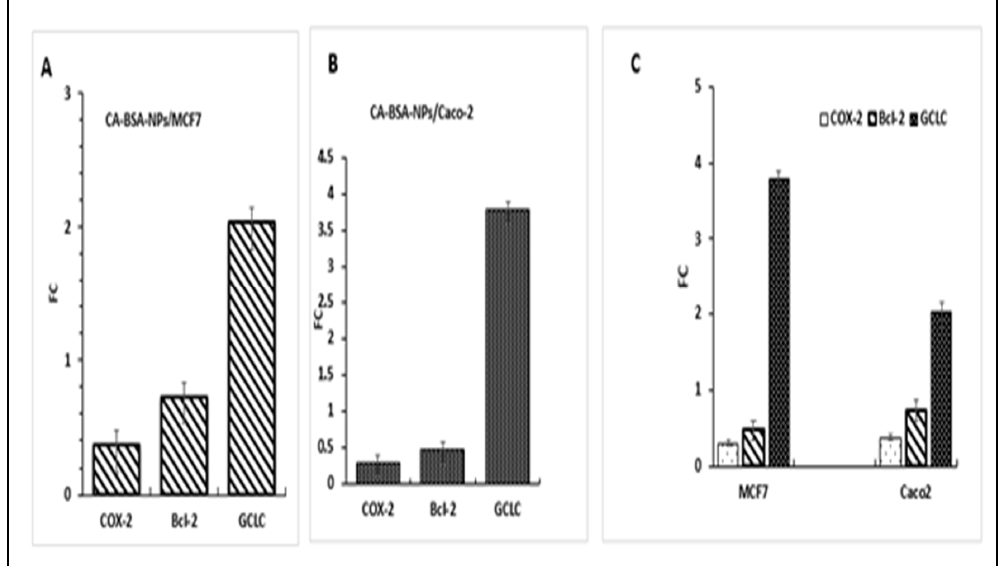
Figure 11. Gene expression profiling. ( A ): Fold change (FC) of GCLC, COX-2, and BCL-2 genes in MCF7cancer. ( B ): Fold change of GCLC, COX-2, and BCL-2 genes in Caco-2 cancer cells. ( C ): Fold change of GCLC, COX-2, and BCL-2 genes inMCF7 and Caco-2 cancer cells.